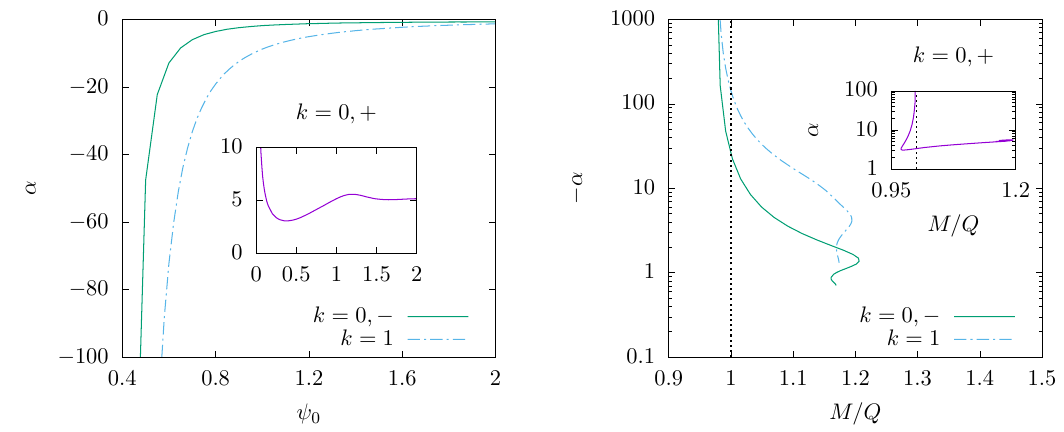
Figure 2 . We show the dependence of the value of the parameter α for which non-trivial solutions of (3.9) exist, on the central value of the complex scalar field forming the boson star, ψ 0 (left), as well as on the ratio between the mass M and the Noether charge Q (right). We present our results for the solutions without nodes, k = 0, for positive α (solid purple, +, see insets of both figures) as well as for negative α (solid green, ) and for the first excited solution, k = 1, (blue dotted-dashed), − respectively. For clarity, we indicate the M/Q = 1 line (dotted black, right).